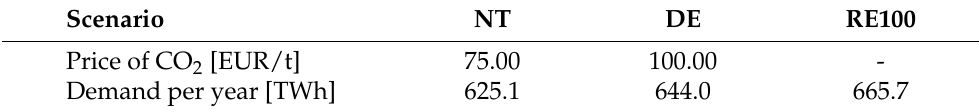
Table 3. Carbon dioxide prices and annual power demand per scenario. Data from [23,24].